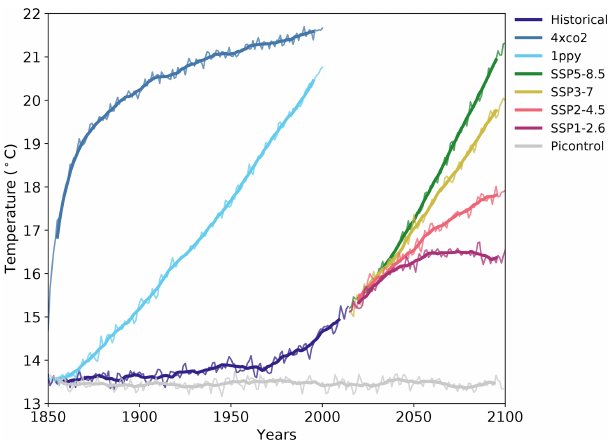
Figure 2. Global average screen temperature in CanESM5 for the CMIP6 DECK experiments, as well as the historical and tier 1 Shared Socioeconomic Pathway (SSP) experiments (SSP5-85, SSP3-70, SSP2-45, and SSP1-26). Thick lines are the 11-year run- ning means; thin lines are annual